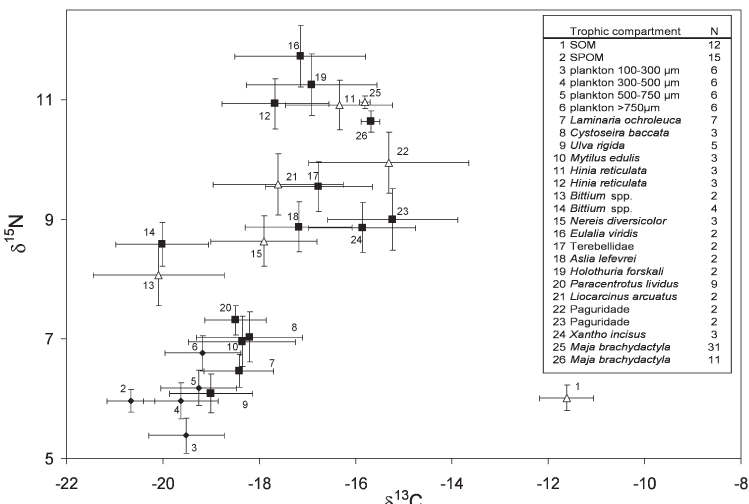
Fig . 5. – isotope ratios of the main compartments of the coastal food web in the Golfo artabro. mean values of δ 15 n and δ 13 C for trophic com- ponents from rocky (squares) and sandy (triangles) benthic habitats and pelagic habitats (circles) are shown. Confidence intervals represent standard error. δ 13 C values for Som are corrected by a factor of -2‰ (see text for the explanation).